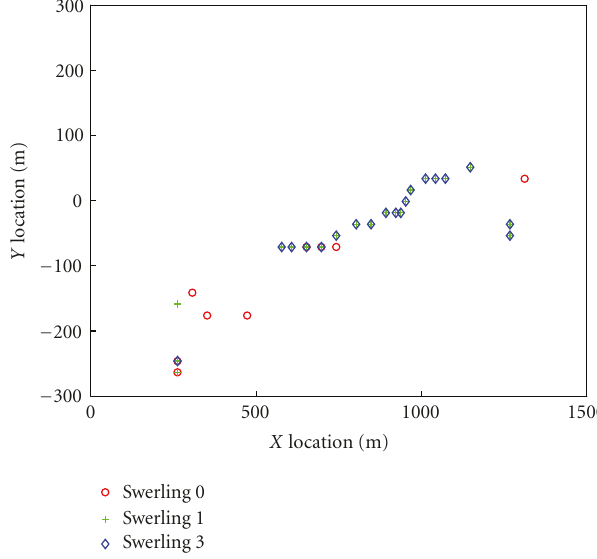
Figure 10: True target detections for Swerling 0, 1, and 3 target model when top three maximum localities are considered.